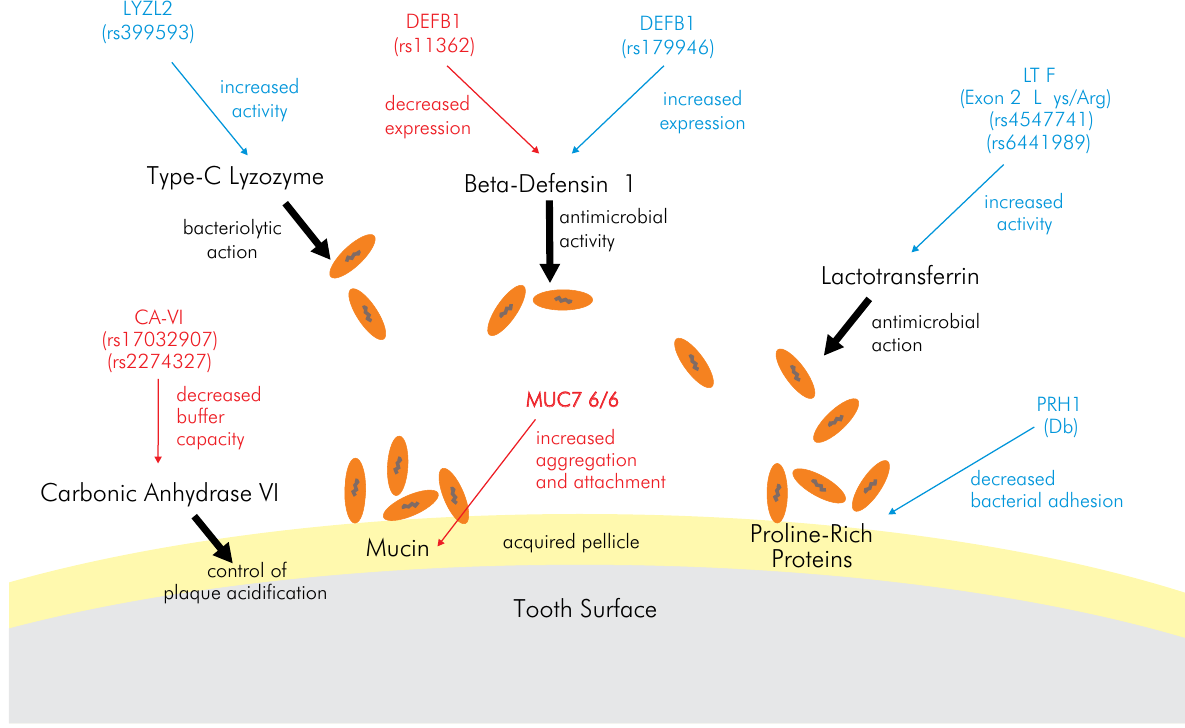
Figure 4. Salivary proteins and functions (black) that present polymorphisms associated positively (red) or negatively (blue) with dental caries